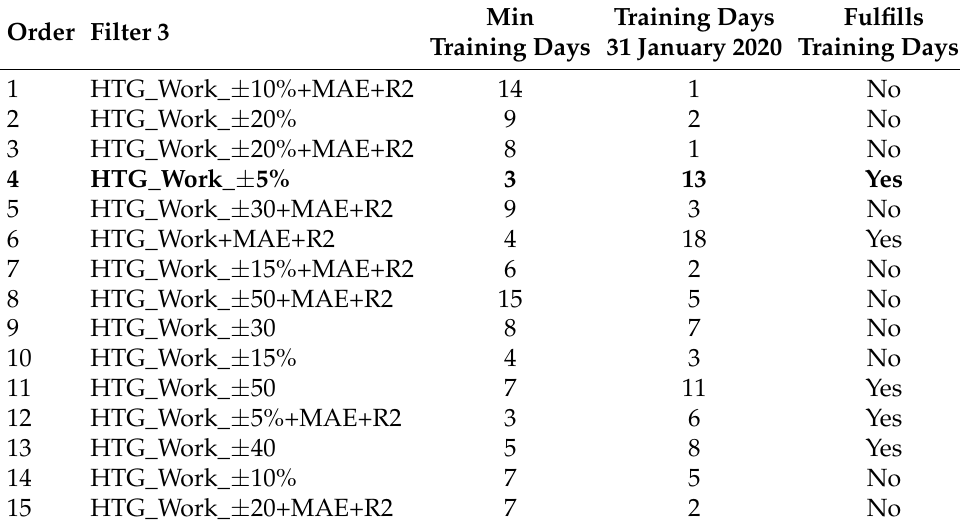
Table 5. Selection of the criterion from Filter 3 (filtered by similar energy demand).